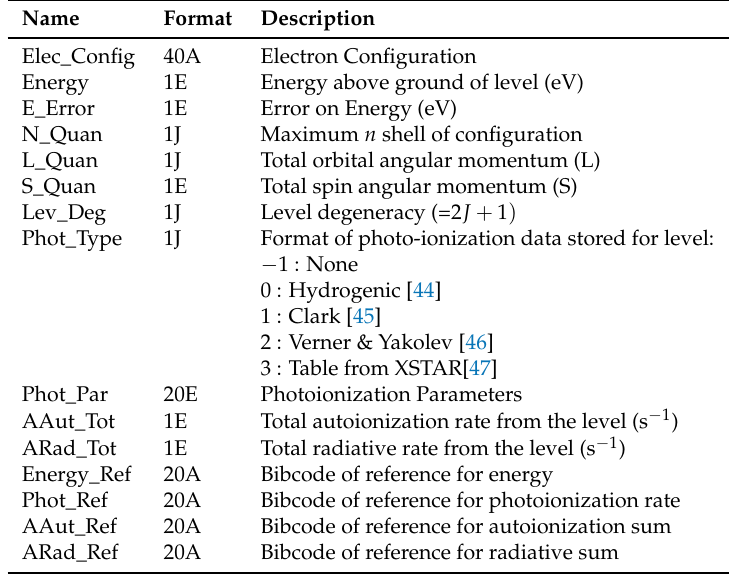
Table A2. APED LV (energy level) file definition.